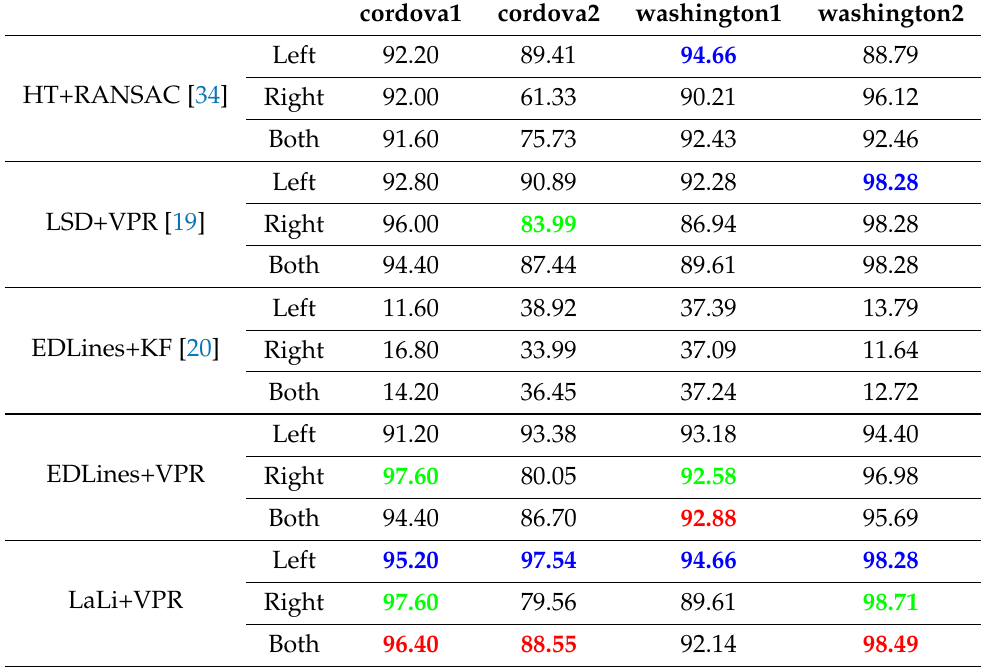
Table 3. Lane detection accuracies on Caltech dataset